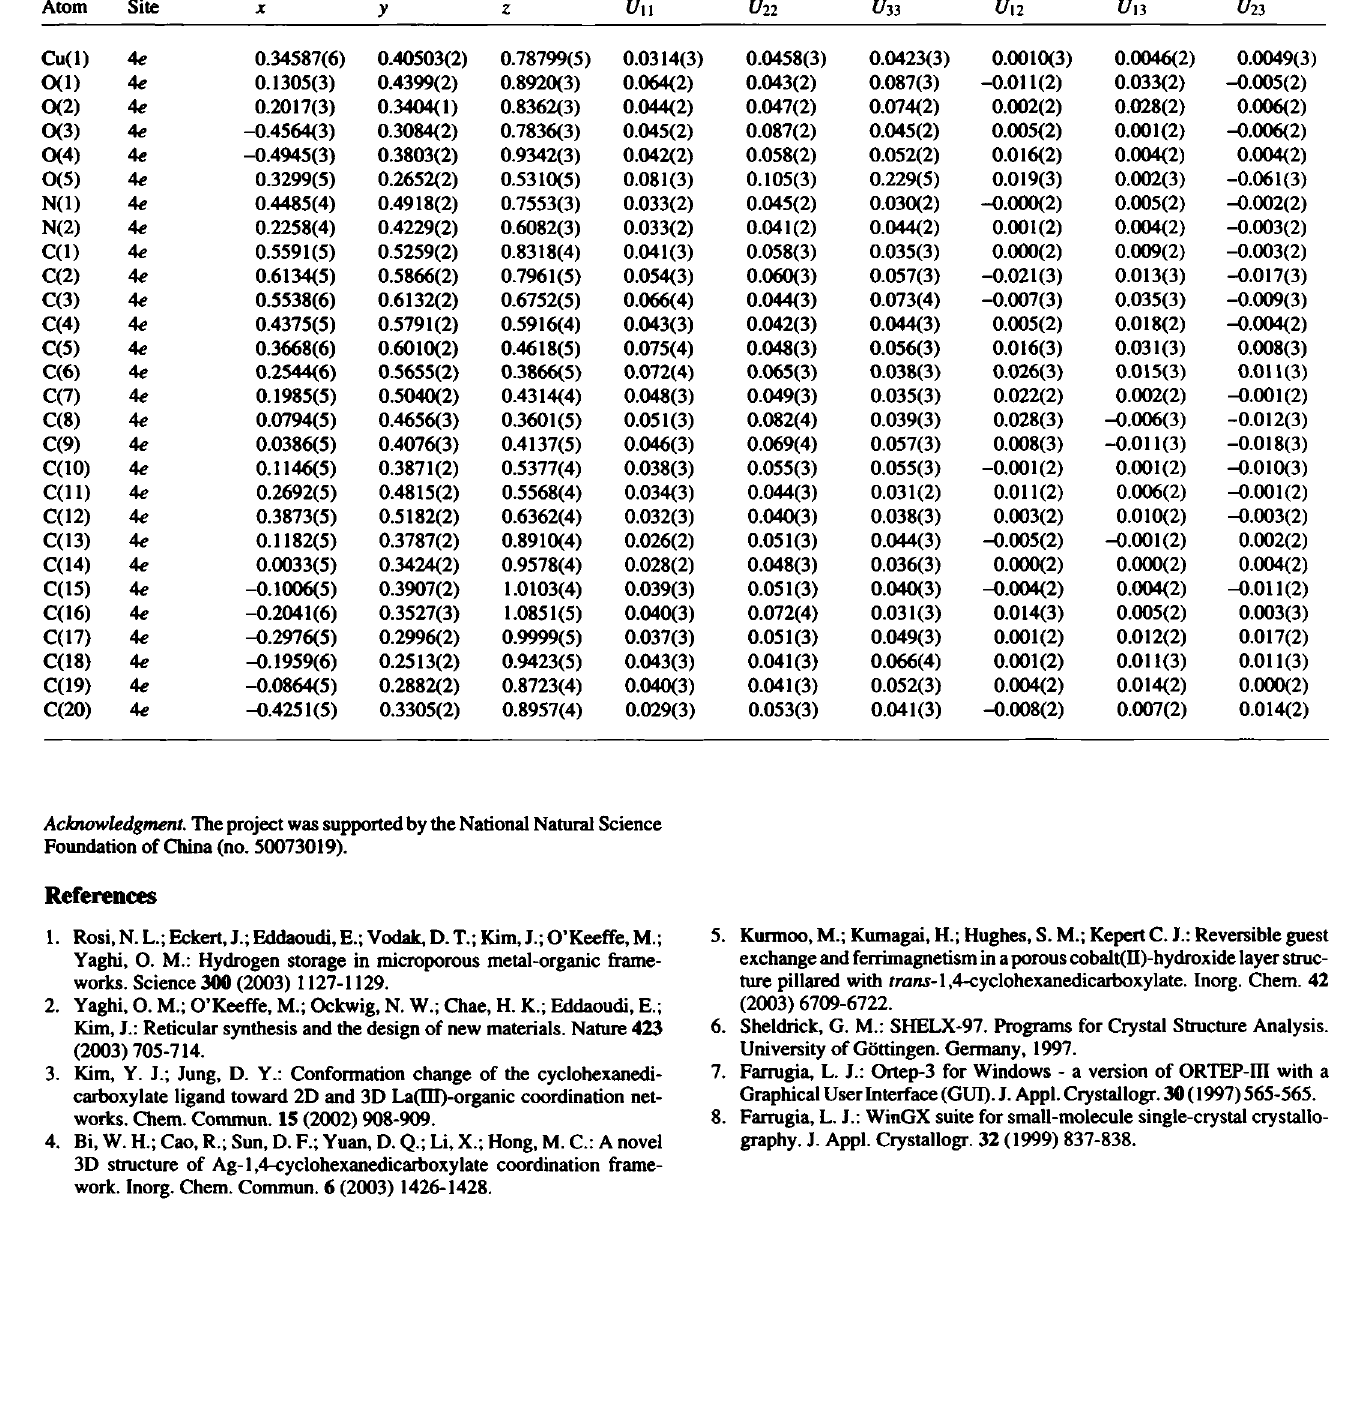
Table 3. Atomic coordinates and displacement parameters (in À 2